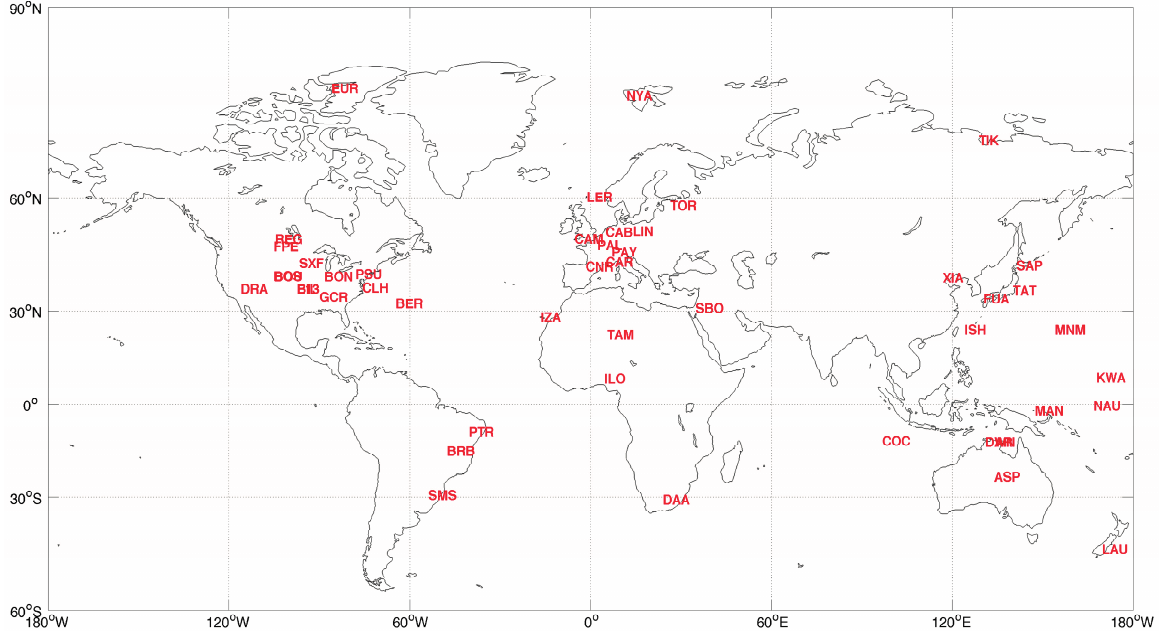
Figure 2. Map of the selected Baseline Surface Radiation Network (BSRN) sites used in this